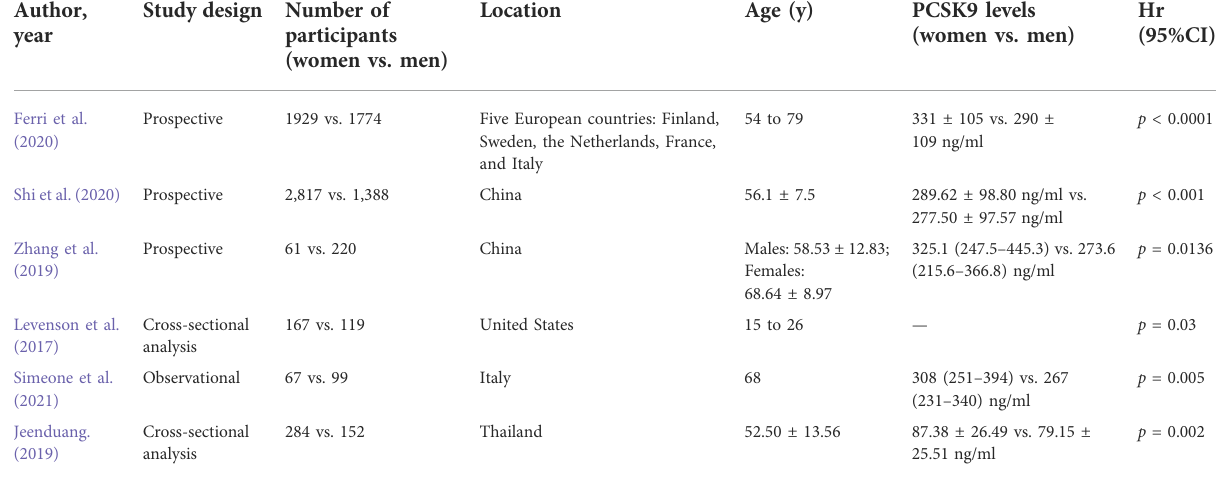
TABLE 1 Demographic features and PCSK9 levels in the observational studies comparing circulating PCSK9 levels between women and